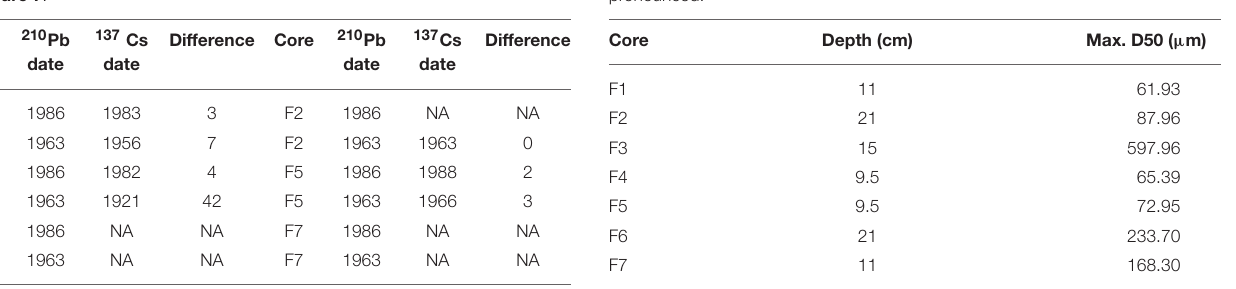
TABLE 2 | Depth and median grain sizes of the sandy layer, where it is most